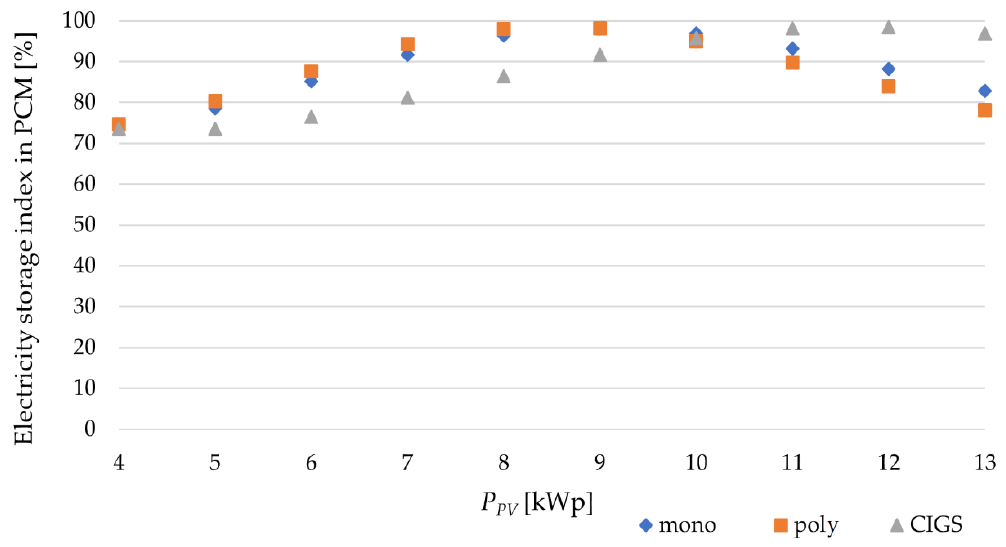
Figure 15. Electricity storage index in PCM as a function of PV power plant power—sunny days.